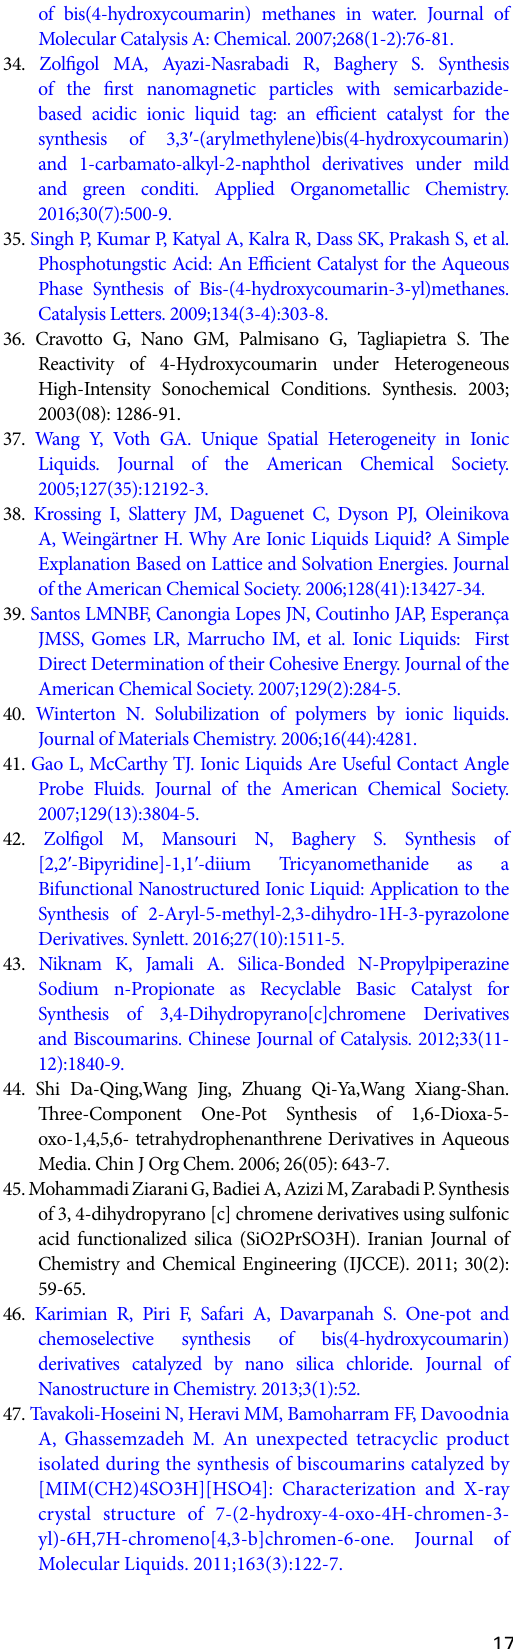
177 Nanochem Res 3(2): 170-177, Summer and Autumn